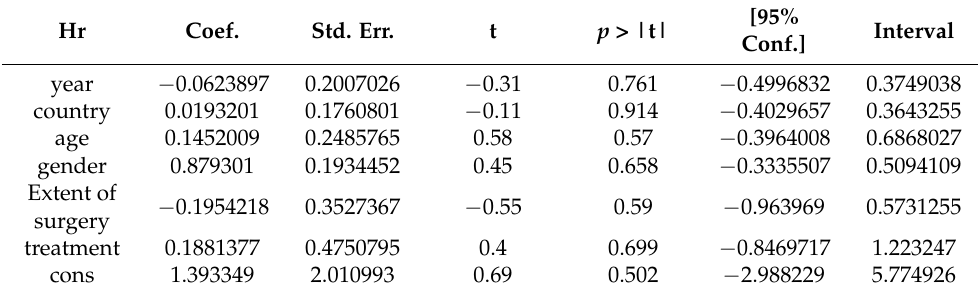
Table 3. Meta-regression of baseline data.